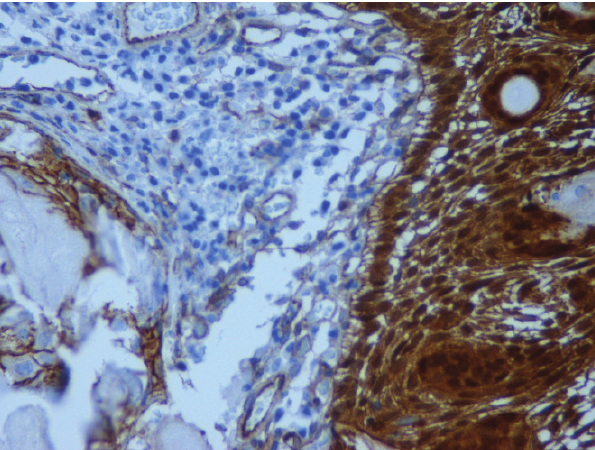
Figure 2 - b -catenin immunohistochemical staining showing the nuclear staining pattern.